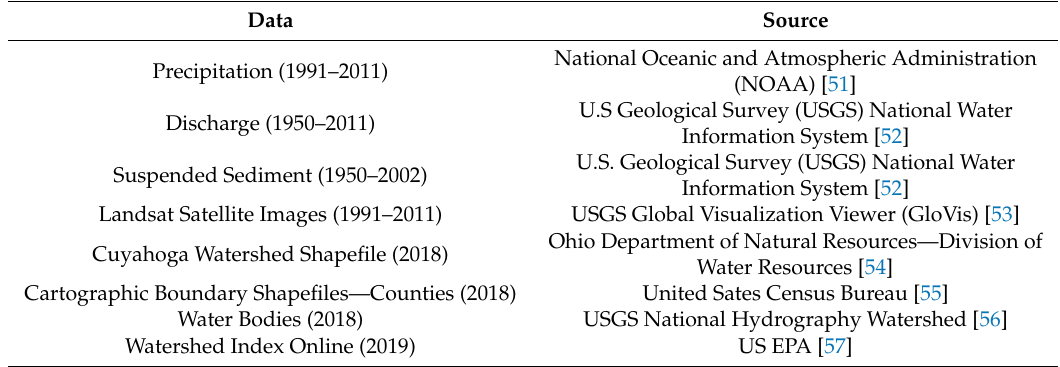
Table 1. Summary of data used in study.